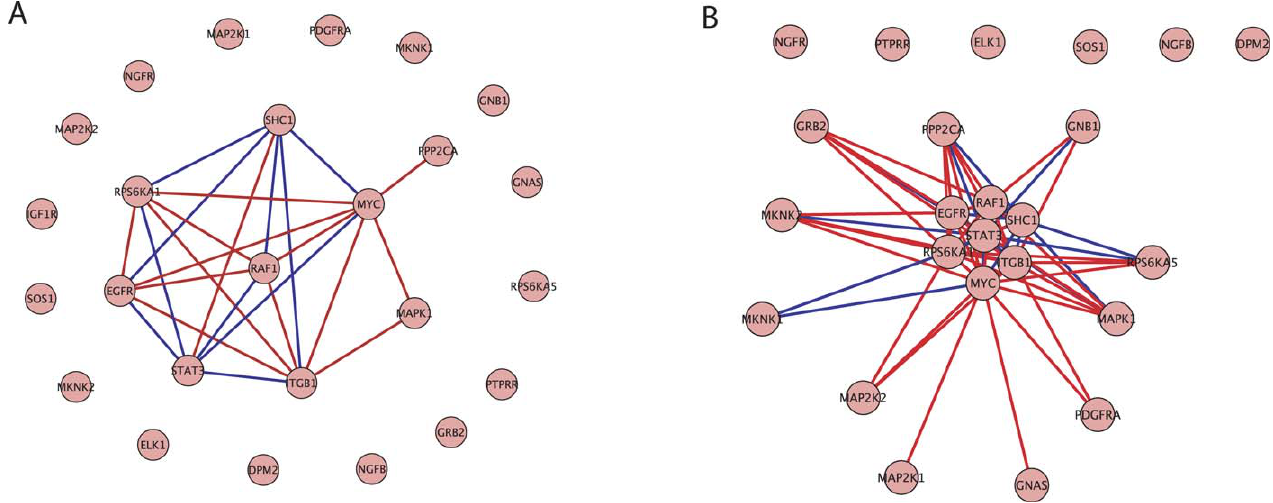
Figure 3. ERK Pathway Gene Association Graphs An association graph of the ERK pathway gene set with (A) a strong threshold on gene dependencies and (B) a weak threshold on gene dependencies. The red lines indicate a positive dependence while the blue lines indicate a negative dependence. Distances between genes reflect the strength of dependence between genes.